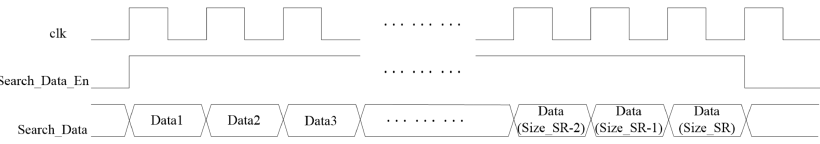
Figure 10. The timing of the search sub-area data output.